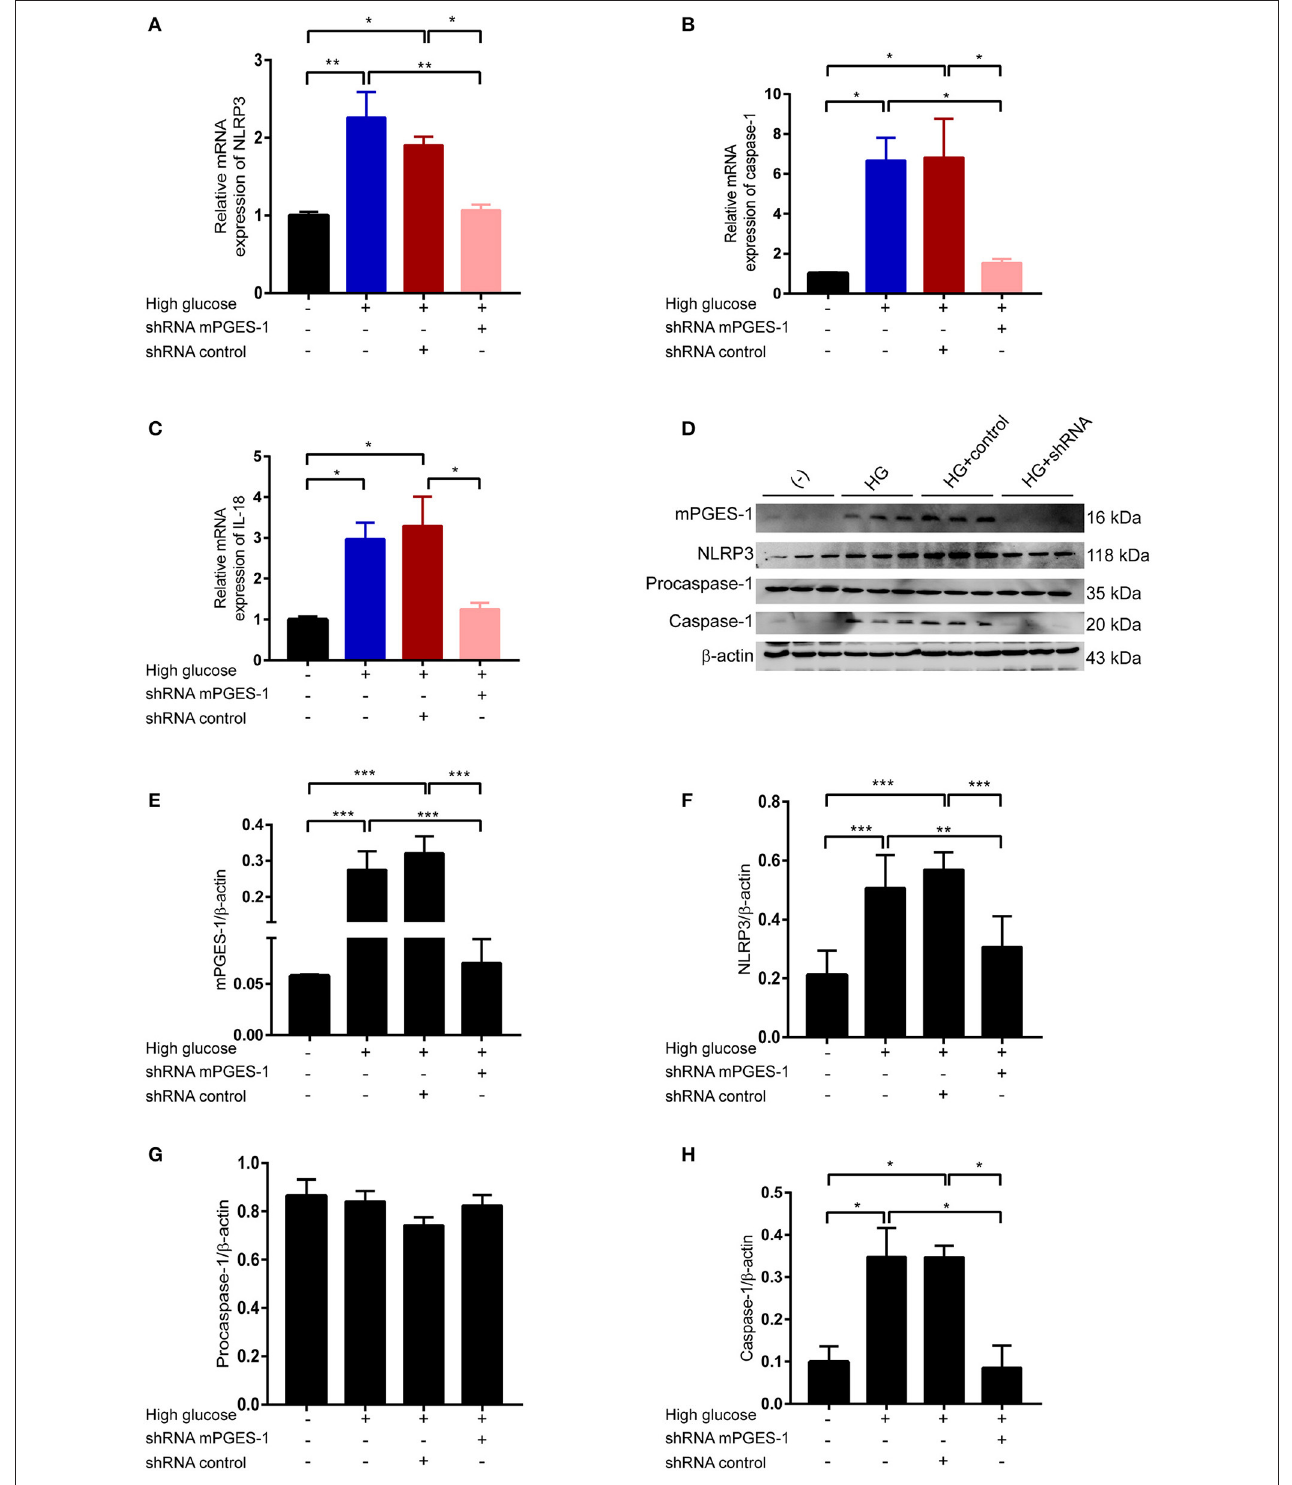
FIGURE 5 | Inhibition of mPGES-1 blunts high-glucose-induced activation of the NLRP3 inflammasome. (A–C) RPMCs were transfected with the mPGES-1 shRNA plasmid or control shRNA plasmid, followed by incubation with high glucose for 24h. Real-time quantitative PCR analysis was used to detect the mRNA levels of NLRP3 (A) , caspase-1 (B) , and IL-18 (C) . (D–H) RPMCs were transfected with the mPGES-1 shRNA plasmid or control shRNA plasmid, followed by incubation with high glucose for 48h. Western blotting confirmed the expression of mPGES-1, NLRP3, procaspase-1, and caspase-1. Quantitative analyses of mPGES-1 (E) , NLRP3 (F) , procaspase-1 (G) , and caspase-1 (H) expression were displayed. The data are represented as the mean ± SEM. * P < 0.05, ** P < 0.01, *** P <